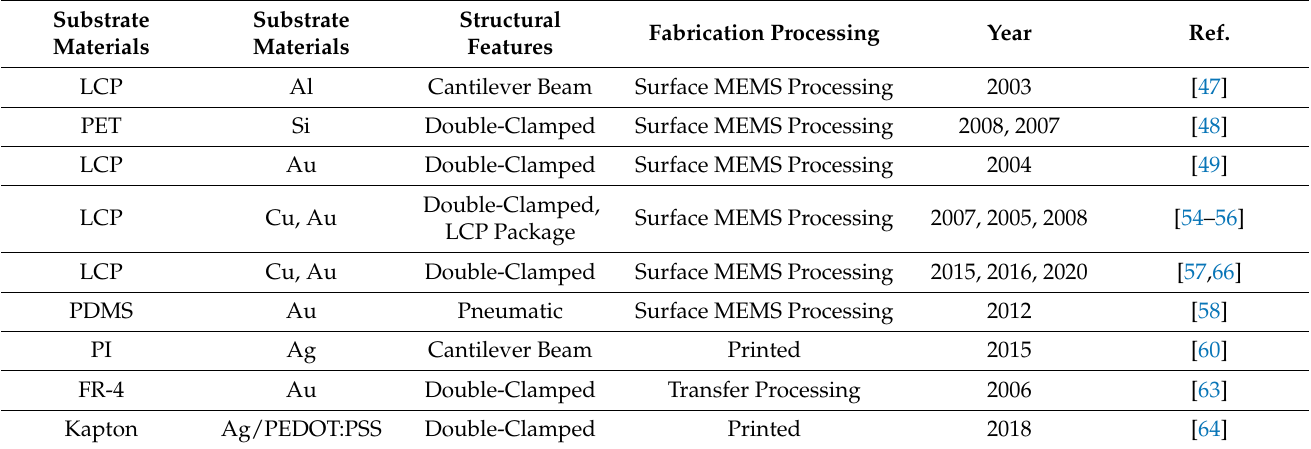
Table 2. Summary of flexible RF MEMS